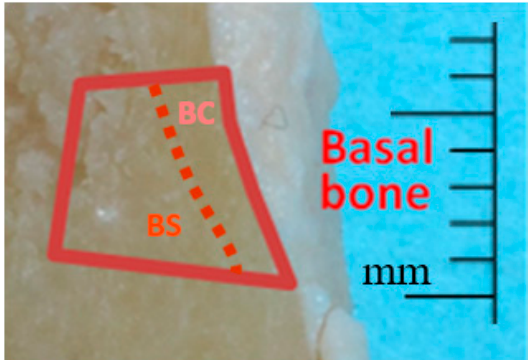
Figure 2. Image showing a representative human mandible jaw section after gross dissection where basal cortical bone samples (BC) and basal spongy bone samples (BS) were harvested to be analyzed for Cd content.